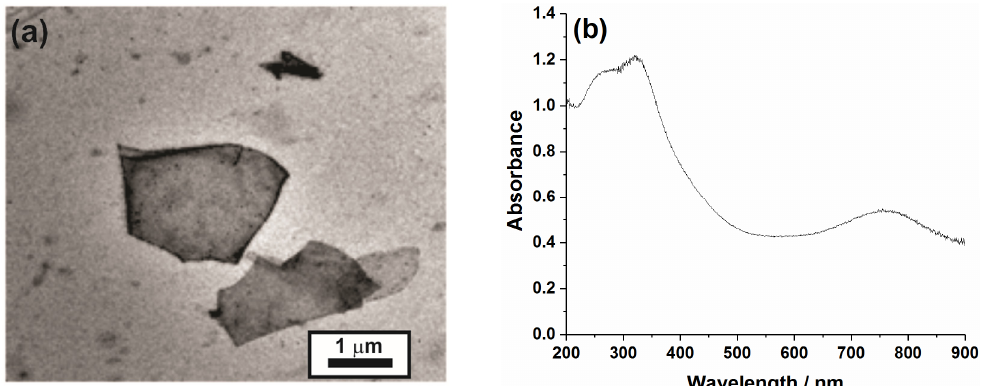
Figure 1. TEM image of delaminated Ti 3 C 2 Т х particles ( a ) and UV–vis spectrum of freshly prepared MXene aqueous colloidal solution ( b ).